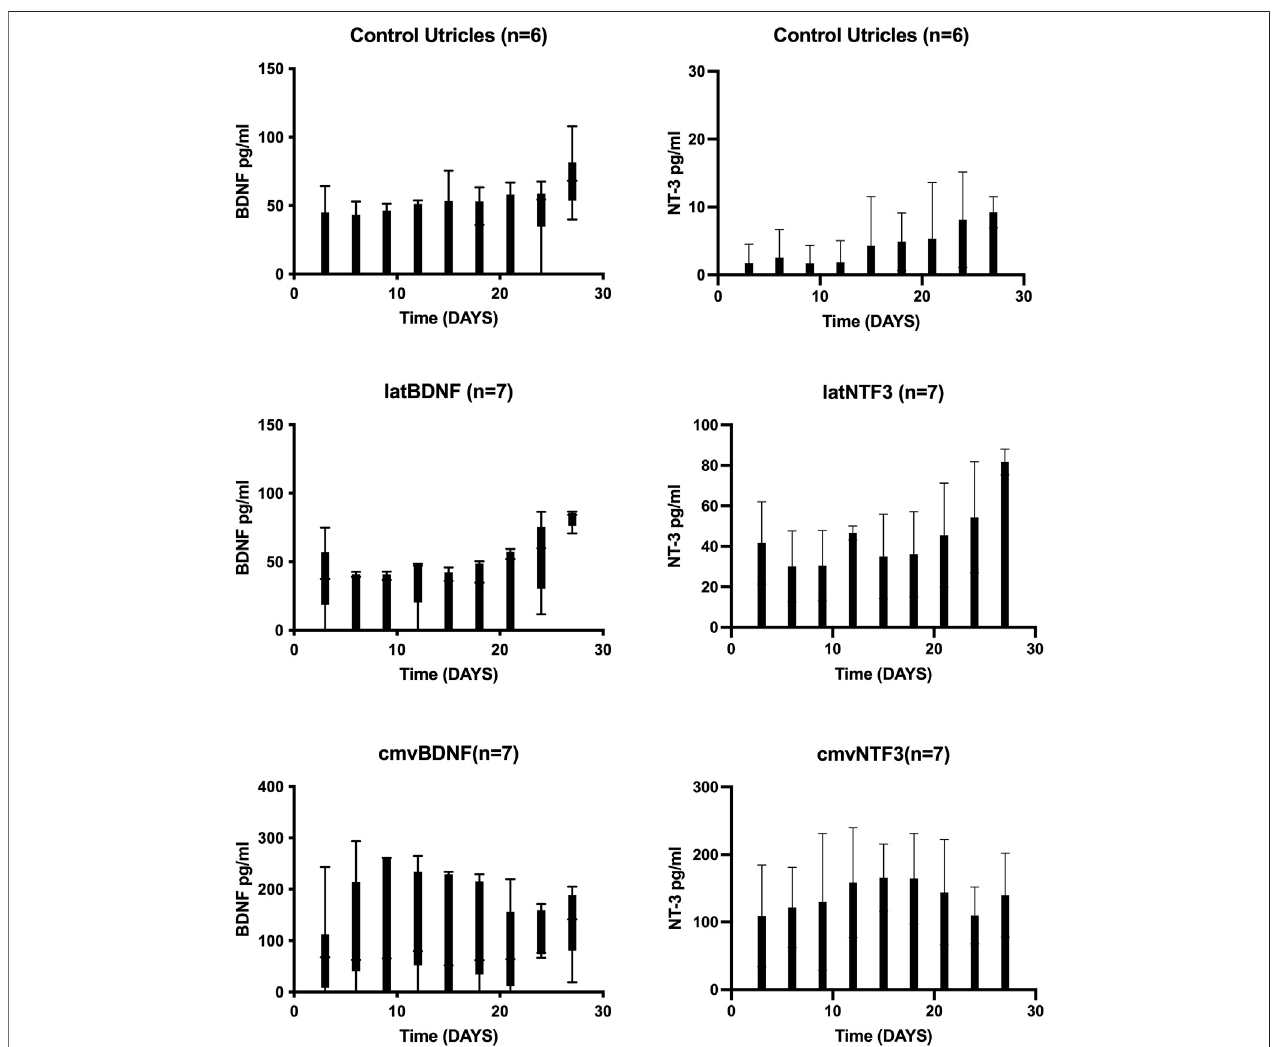
FIGURE1| ExpressionofBDNFandNT-3inneomycin-treatedutricleculturesovertime.Adultmouseutriclesweretreatedwithneomycinfor48 handmaintained in vitro for1 month.Controlsweremaintainedin de fi ned medium, and experimental groups were treatedwithan Ad28vectordelivering theBDNF orNTF3 genes driven either with the herpes latency promoter or the human CMV promoter. Medium was exchanged every 72 h, and BDNF or NT-3 levels were determined by ELISA. Error barsrepresentstandarddeviation.ControlsandthelatpromotergroupsshowedalowproductionofBDNFatthelimitsoftheELISAsensitivity.Utriclestreatedwith theCMV-drivenBDNFshowedsteadygrowthofBDNFexpressionoverthe fi rst10 days invitro thatwasmaintainedathighlevelsforthedurationoftheexperiment.NT- 3 was barely detectable in control utricle explants. NTF3 driven by the lat promoter produced a low level of NT-3, whereas use of a CMV promoter resulted in higher expression levels of